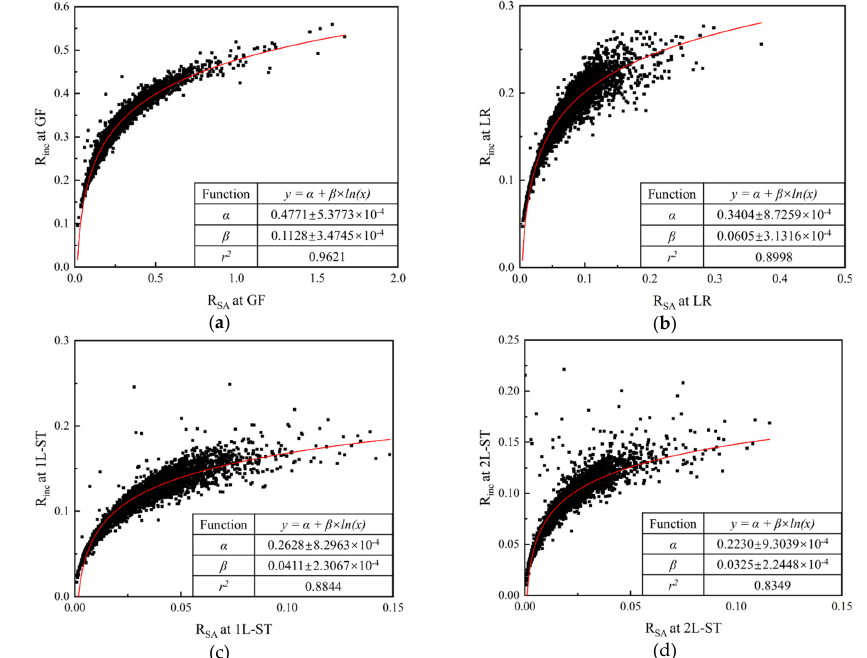
Figure 8. Relationship of R inc and R SA at different RLS: ( a ) general form (GF); ( b ) local roundness (LR); ( c ) first-level surface texture (1L-ST); ( d ) second-level surface texture (2L-ST).